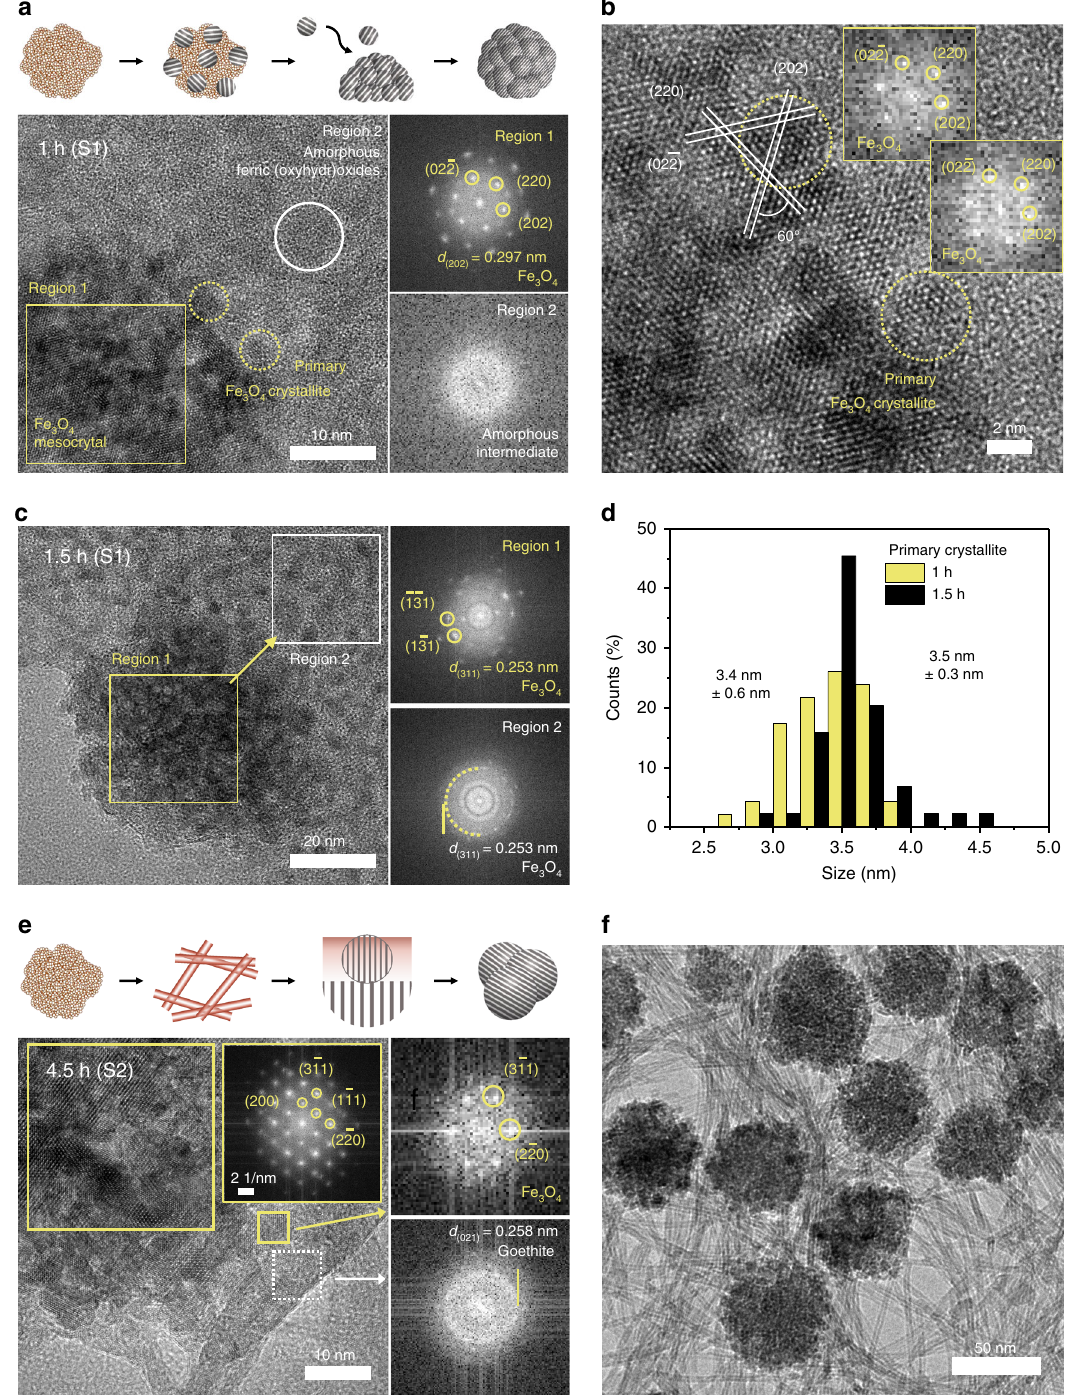
Fig. 3 Microstructural analysis of crystallization pathways. a TEM analysis of Fe 3 O 4 mesocrystals of S1 after re fl uxing for 1 h. b HRTEM image showing FFT images of primary crystallites attached to the surface of mesocrystals in S1 after re fl uxing for 1 h. c TEM images and FFT patterns of S1 after re fl uxing for 1.5 h. The Regions for FFT patterns are indicated in each bright fi eld image of a – c . The phase and corresponding d-spacing of the FFT patterns are denoted in each panel. d Sizes of primary crystallites after 1 and 1.5 h of re fl uxing. A Gaussian distribution is obtained from the measured sizes of n = 50 mesocrystals. e HRTEM image and FFT patterns of S2 after re fl uxing for 4.5 h. The FFT pattern shows d-spacing of spots derived from the magnetite and goethite closest to the center. f Bright- fi eld image of S2 after re fl uxing for 4.5